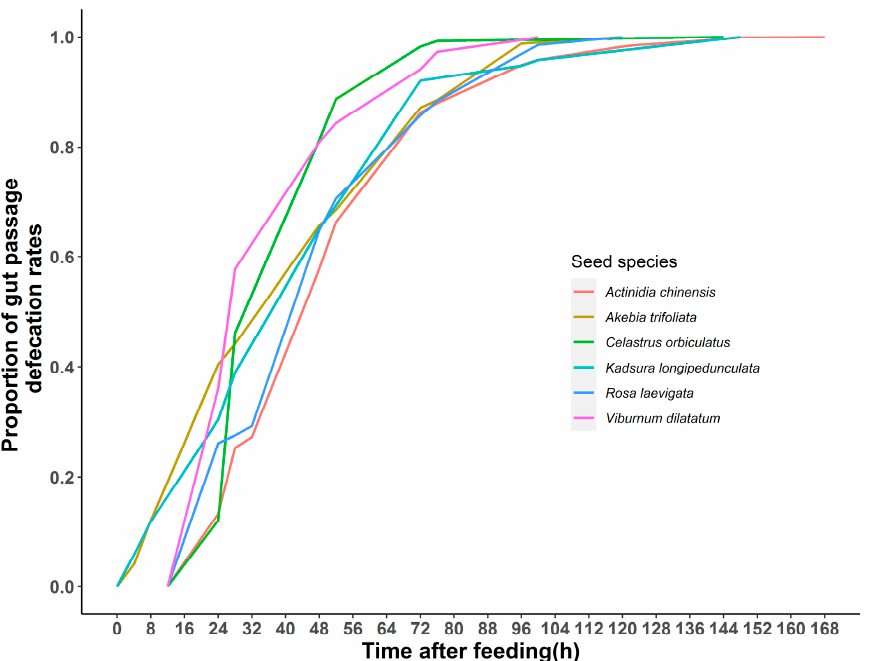
Figure 3. Cumulative distribution of gut passage time through the digestive tract of captive Tibetan macaques of six seed species. Gut passage rates are averaged across five rounds of experiments.